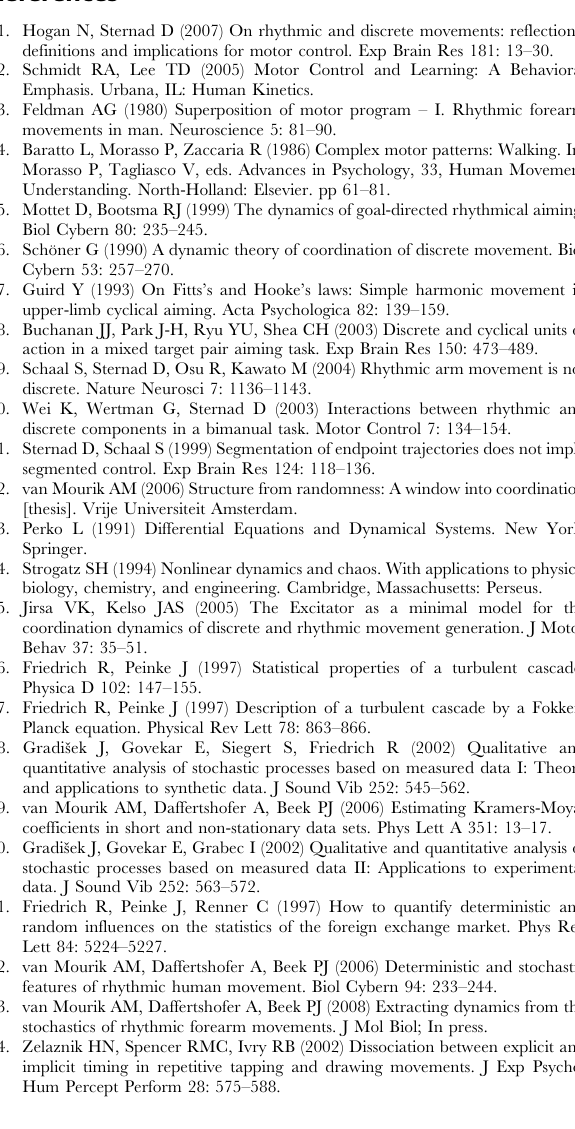
frequency values are plotted in the reverse order of which they were performed. Figure S7 Goal frequency versus coefficient of variation. Note that in conditions where participants were slowing down, the CVs are plotted in the reverse order of which they were performed. Figure S8 Goal frequency versus normalized mean squared jerk. Note that in conditions where participants were slowing down, the values of jerk are plotted in the reverse order of which they were performed. Figure S9 Goal frequency versus percentage of time to peak negative velocity. Note that in conditions where participants were